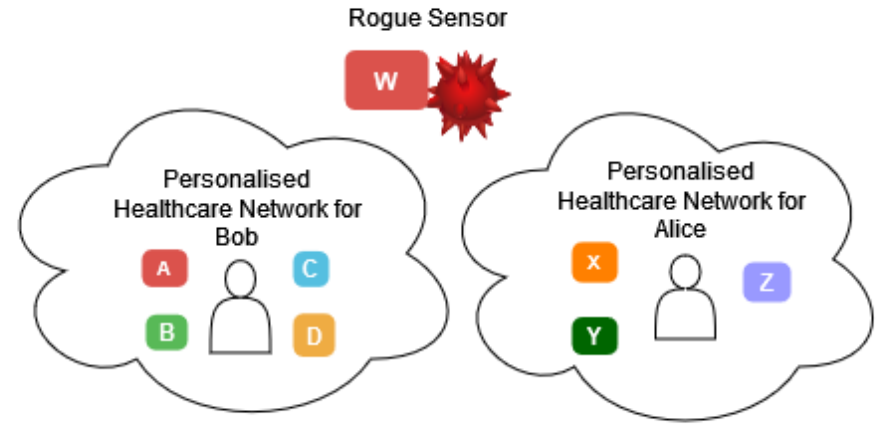
Figure 2. Scenario: Single User